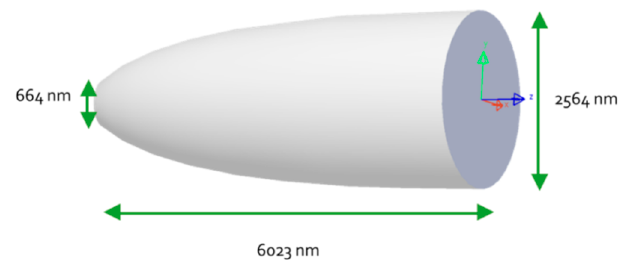
Figure 12. CPC dimensions obtained with LightTools software.